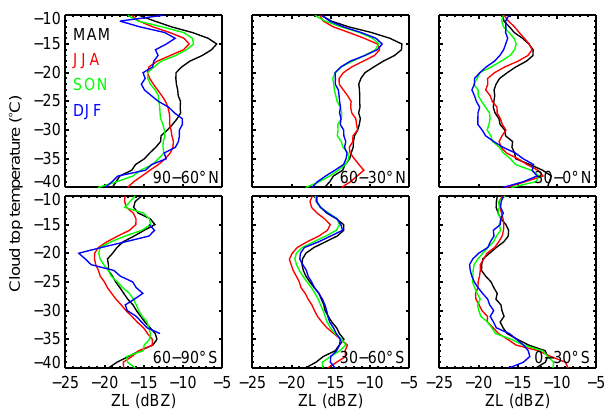
Figure 7. Similar to Fig. 3b, except for the seasonal variations in mean ZL of clouds as a function of